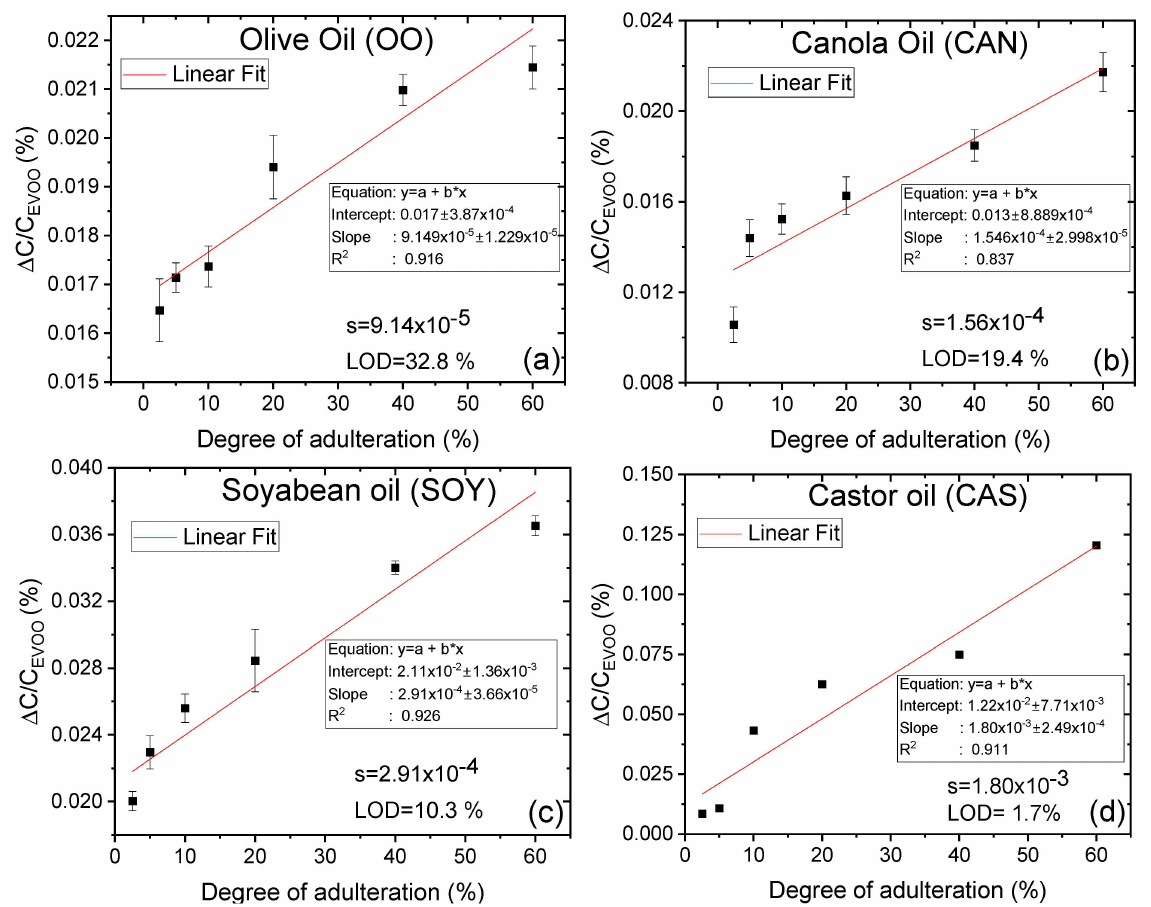
Figure 7. Sensor calibration curves with linear fitting: ∆ C EVOO /C EVOO vs. degree of adulteration (%) in EVOO mixed with ( a ) OO, ( b ) CAN, ( c ) SOY and ( d ) CAS, respectively. Extra virgin olive